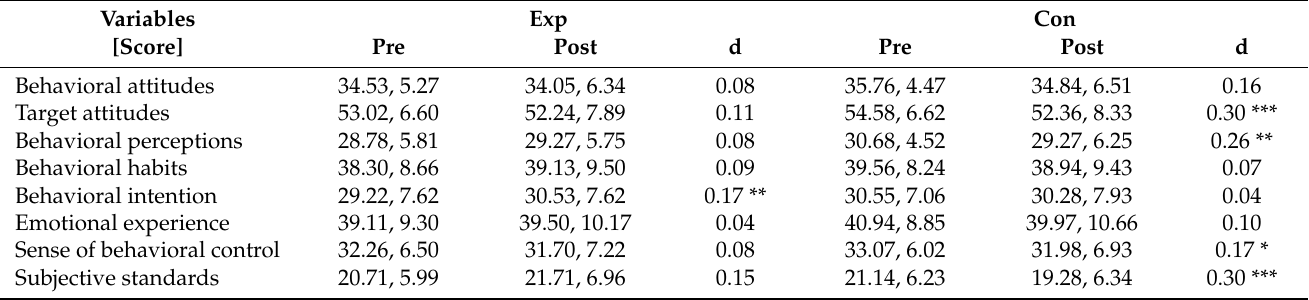
Table 7. Descriptive statistics of exercise attitude (mean, standard deviation); within-group